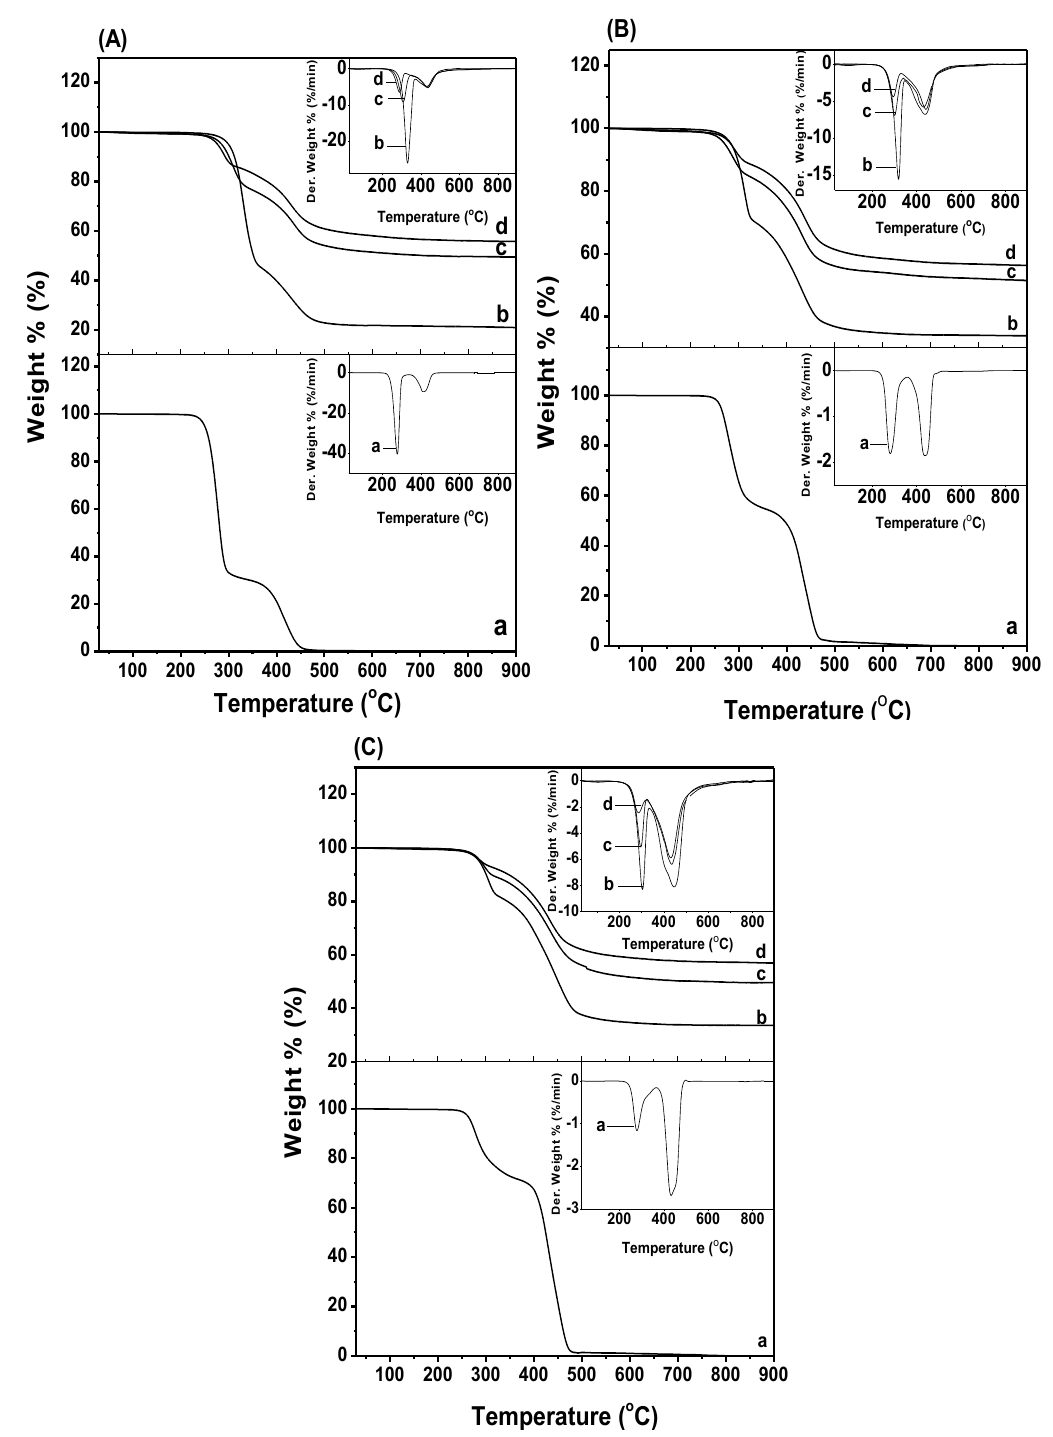
Figure 6. TG-DTG curves of PHB/ENR-50 blend composition of ( A ) 70/30; ( B ) 50/50; and ( C ) 30/70 containing ( a ) 0, ( b ) 1, ( c ) 3, and ( d ) 5 wt%